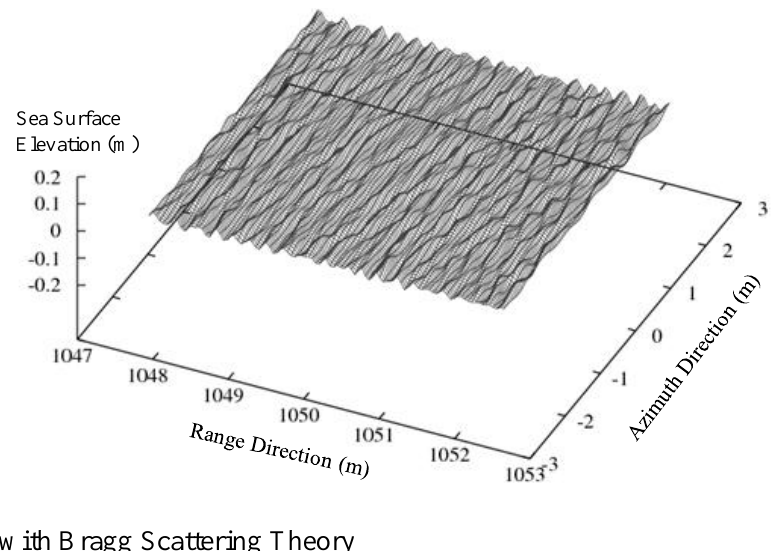
Figure 15. Example of numerical sea surface for irregular wind wave (wind speed 5